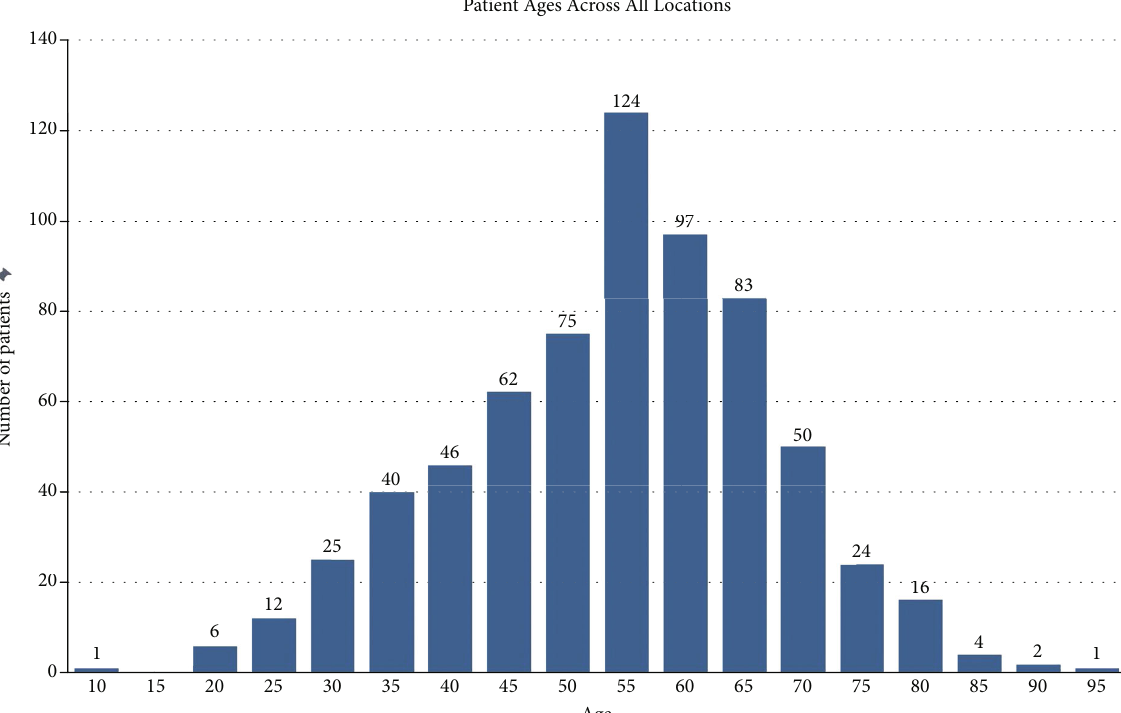
Figure 1: Age distribution of patients